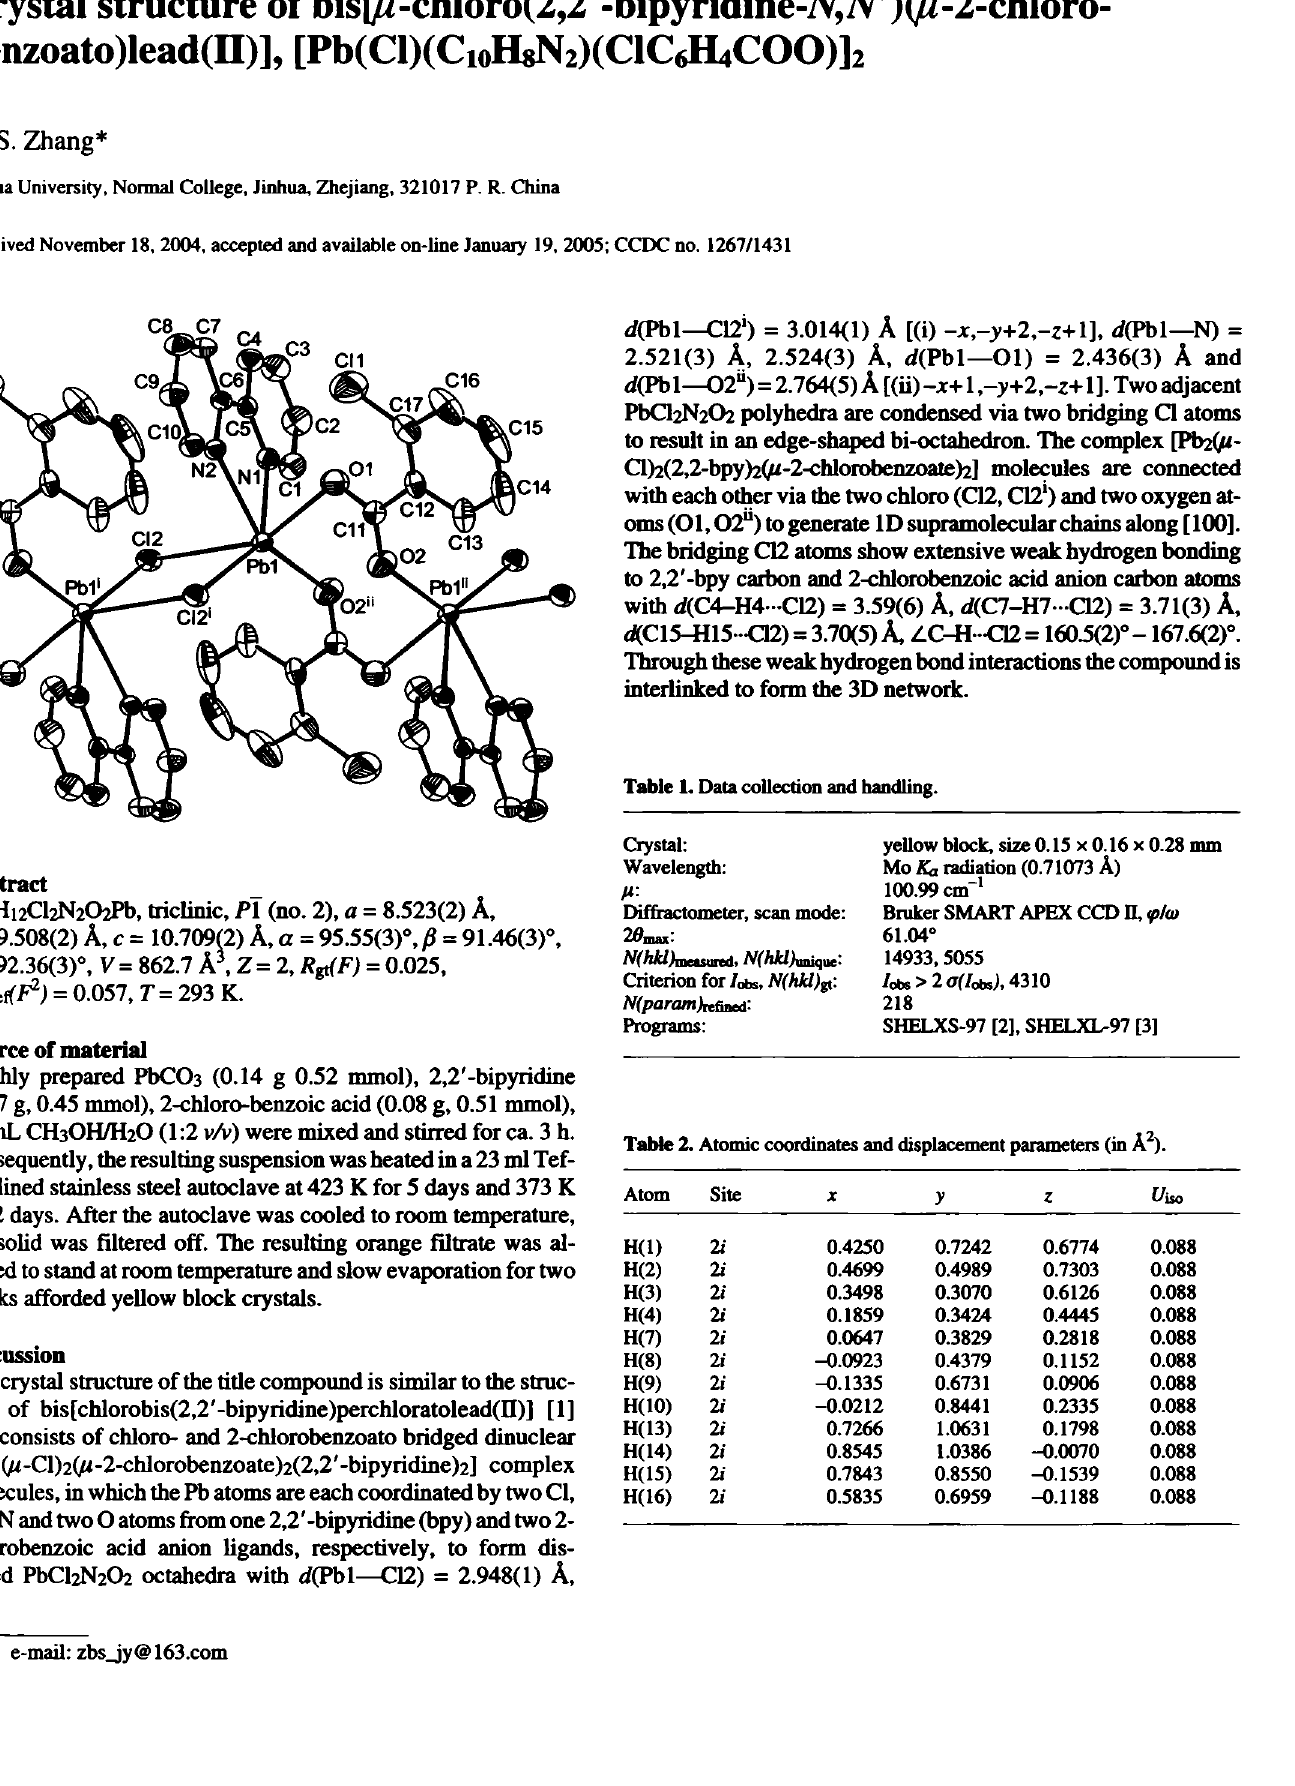
Table 1. Data collection and handling.